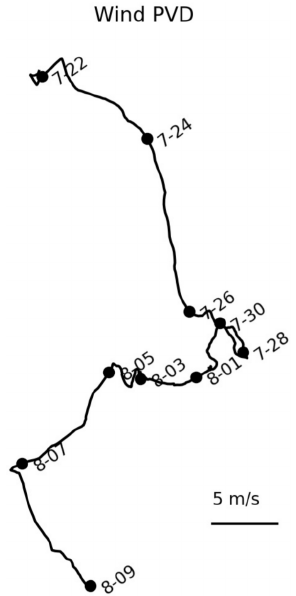
Figure 2. Wind direction and intensity at Bilbao’s mooring buoy represented on a progressive vector diagram